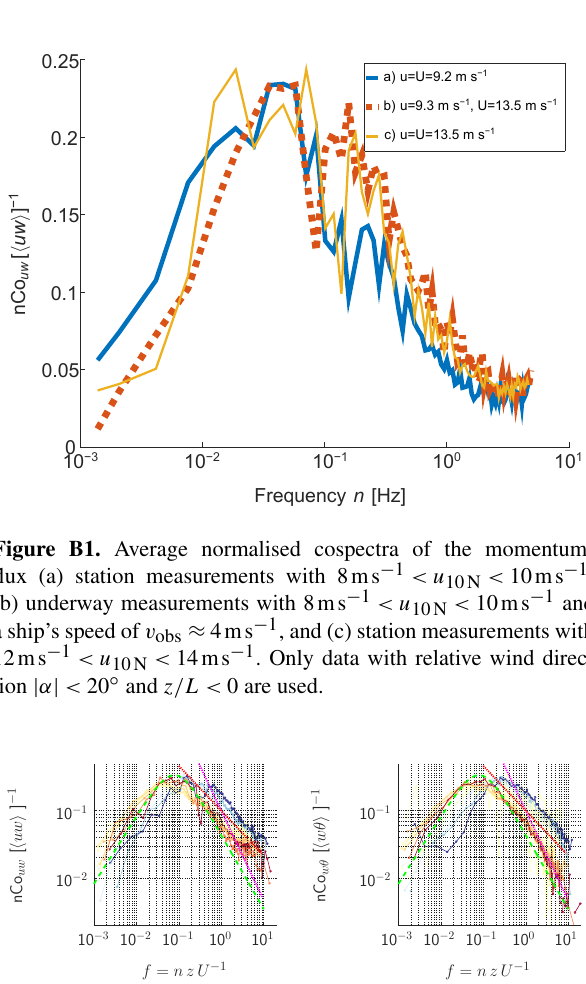
w (cid:48) , the optimal time lag was found by searching for the (t + δt) (cid:105) within a reason- maximum covariance (cid:104) w (cid:48) (t)x (cid:48) CO 2 able range of δt = 0–3 s. For both IRGAs (dryA and dryB), the average optimal time lag was (cid:104) δt (cid:105) = 1 . 50 ( ± 0 . 15 ) s. In- dividual δt that deviated more than two samples from (cid:104) δt